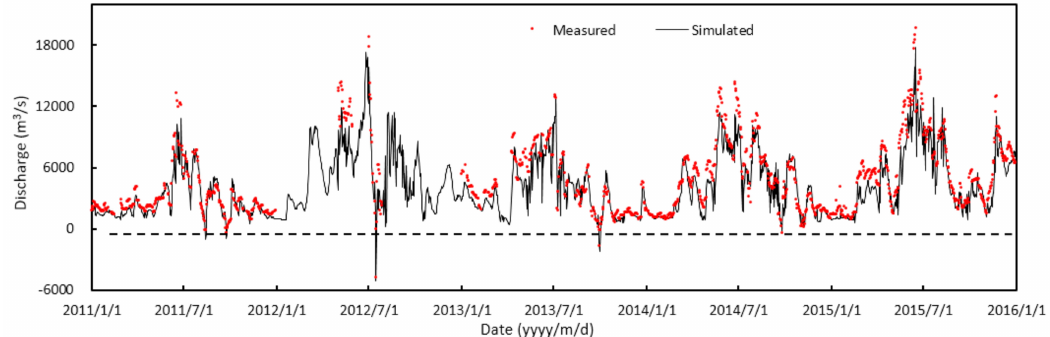
Figure 5. Comparison between model results and observations of outlet discharge at